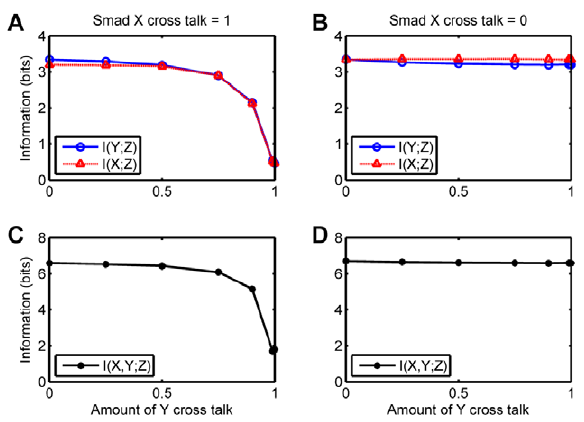
Figure 6. Mutual information as a function of cross-talk for Smad Model C when the cross-talk is varied asymmetrically. ( A and C ) Cross talk for the receptor for X with its non-cognate Smad held at 1 . ( B and D ) Cross talk for the receptor for X with its non-cognate Smad held at 0 . ( A and B ) Partial mutual information. ( C and D ) Total mutual information.